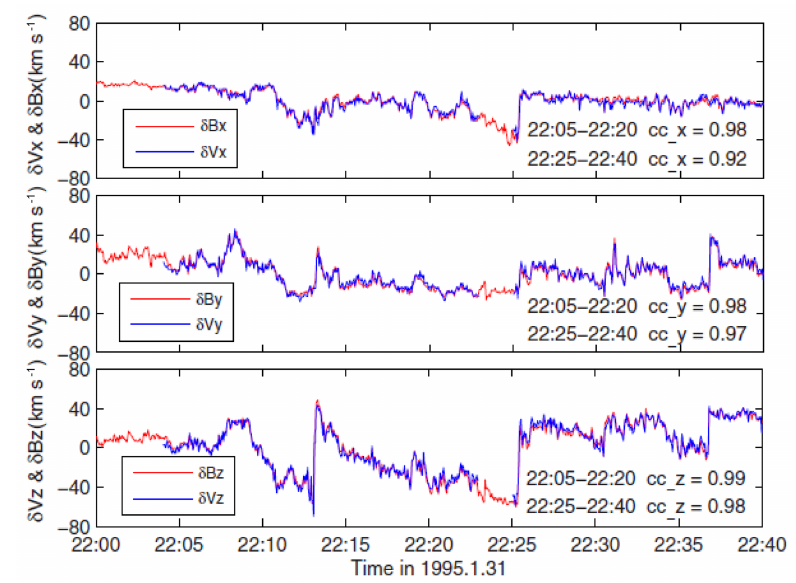
Figure 1. Alfvén waves (Wang et al., 2012) with very high correlations between the fluctuations of the Cartesian components of the magnetic field vector and flow velocity vector evaluated in the de Hoffmann–Teller frame. The respective correlation coefficients (cc’s) are also